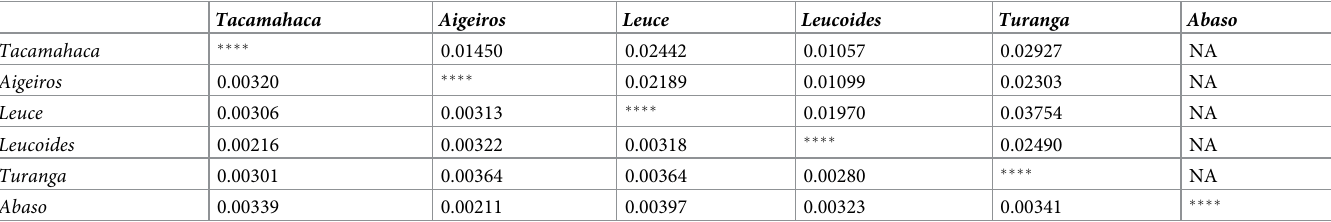
Pairwise distances calculated using the chloroplast combination data are showed below the diagonal, and those calculated using the ITS data are shown above the diagonal. “NA” indicates absent